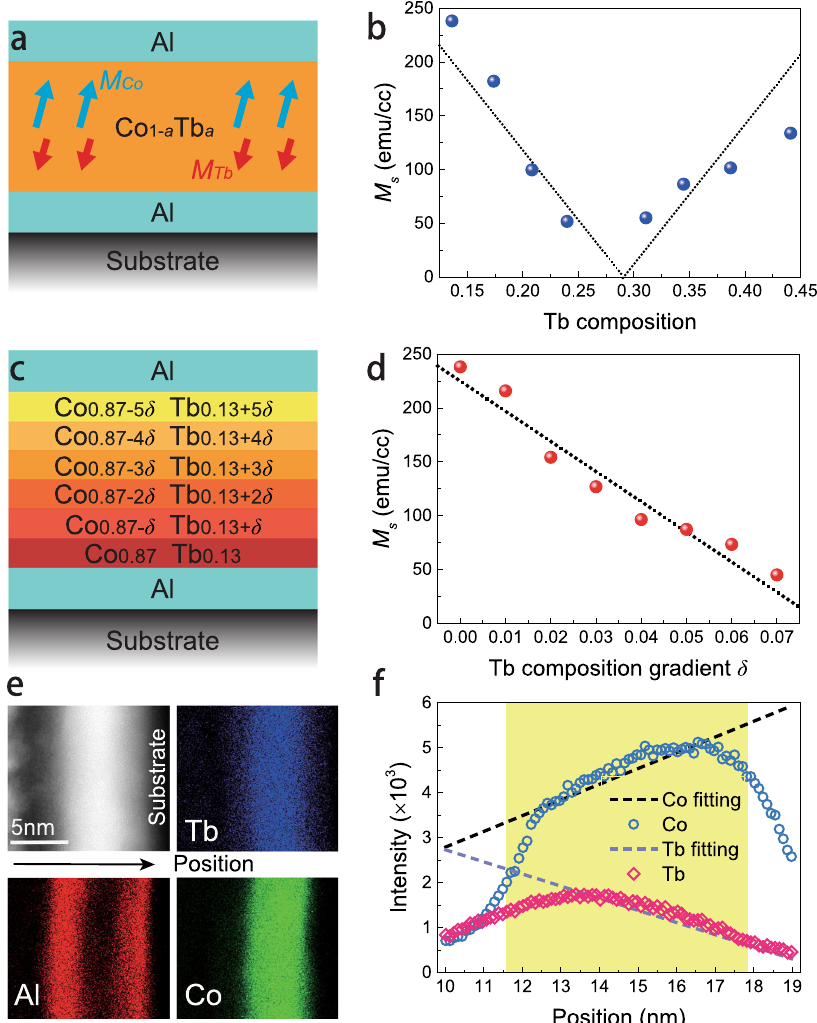
Fig. 1 Structure and characterization of CoTb fi lms with a vertical composition gradient. a Structure of the homogenous Co 1- a Tb a samples. b Net magnetization dependence on the Tb concentration in homogenous CoTb samples. A clear magnetization compensation point is found at the point where Tb concentration equals 0.29. c Structure of the CoTb samples with composition gradient δ . d Net magnetization dependence on δ , showing a linear decrease. e STEM images of the sample with δ = 0.07. f EDS-measured Co and Tb intensity in the sample as a function of vertical position. Co and Tb concentrations show opposite slopes, which veri fi es the existence as well as the direction of the composition